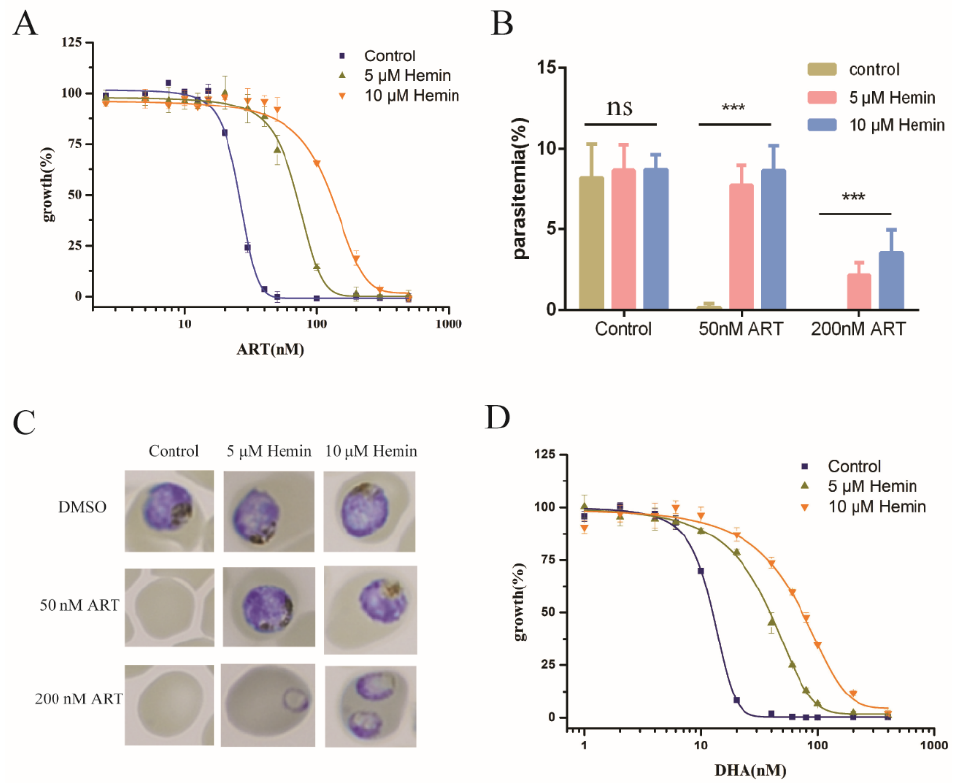
Figure 1. Antimalarial effectiveness of artemisinin was reduced by exogenous hemin. ( A ) Inhibitory effect of artemisinin was decreased with the addition of exogenous hemin. ( B ) Hemin antagonized with artemisinin in inhibiting parasite multiplication, suppressing the parasitemia of P. falciparum. ( C ) Hemin released the inhibition of artemisinin on the development of the parasites after 72 h incubation. ( D ) Similarly to artemisinin, augmenting heme levels through hemin decreased sensitivity of the parasite to DHA. ART: artemisinin, DHA: dihydroartemisinin. Data are mean ± SD of three independent experiments. The data were analyzed by GraphPad Prism. *** p -value < 0.0005, and ns means no significant change ( p -value > 0.05).